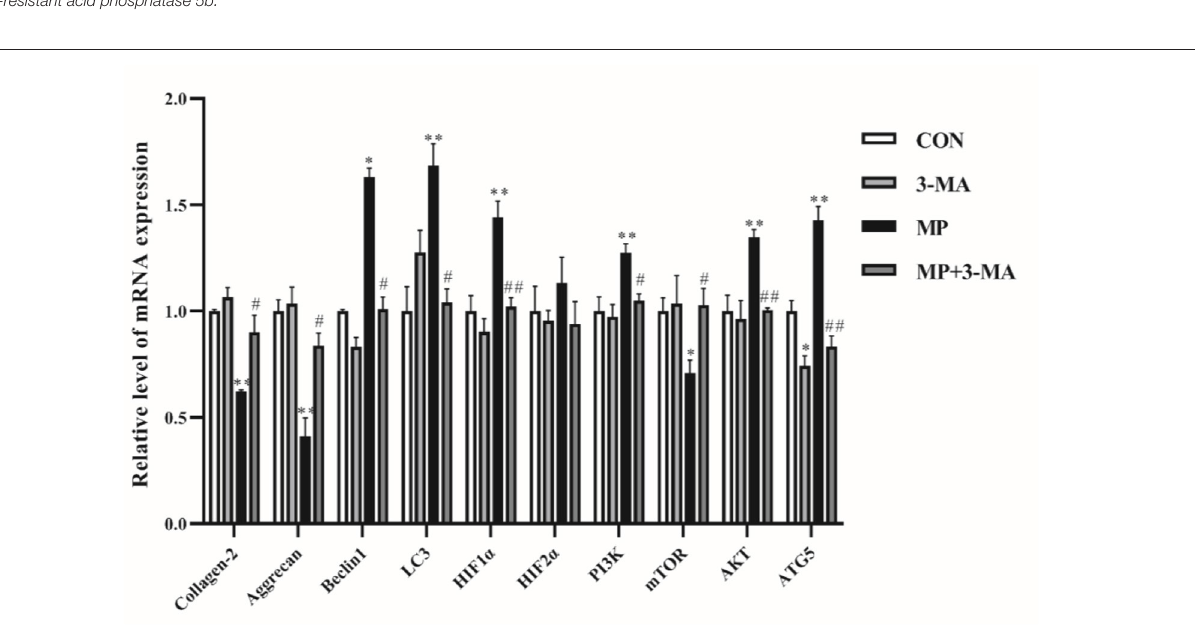
FIGURE 3 | mRNA expression of autophagy relative genes. Effects of 3-MA alone were examined by reverse transcription-quantitative polymerase chain reaction. No significant difference was detected ( P > 0.05). Broilers were co-treated with MP and 3-MA. * P < 0.05 vs. control group; ** P < 0.01 vs. control group; # P < 0.05